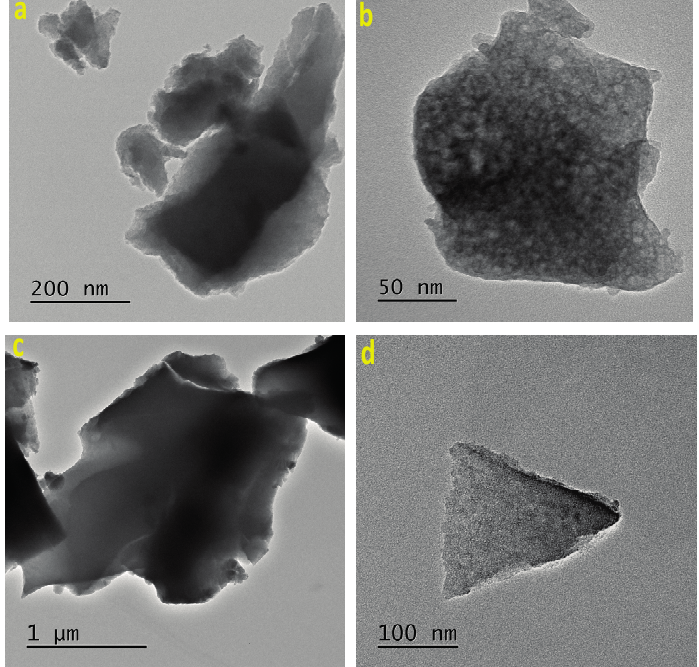
Figure 5. TEM images of a xerogel containing the (OH)AlTSPc species trapped within the pores of ZrO 2 ( a , b ) and TiO 2 ( c , d ) networks.